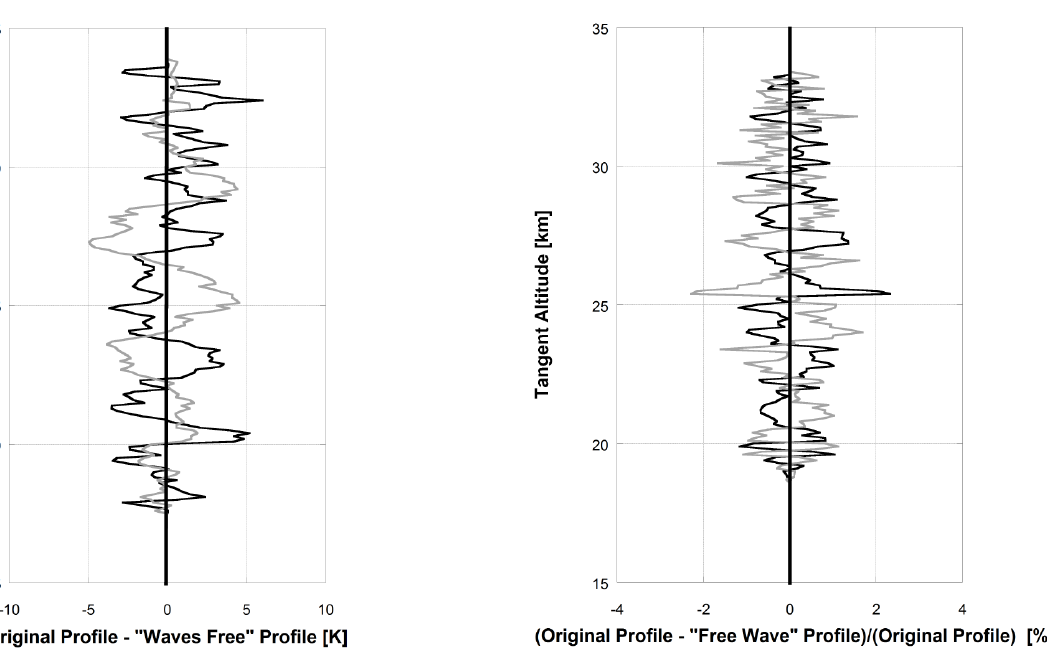
Figure 4. Wavy structure profiles: GOMOS (black line) and SHADOZ (grey line). Note that in this example the GOMOS and the SHADOZ perturbation profiles are obtained from the temper- ature profiles illustrated in Figure